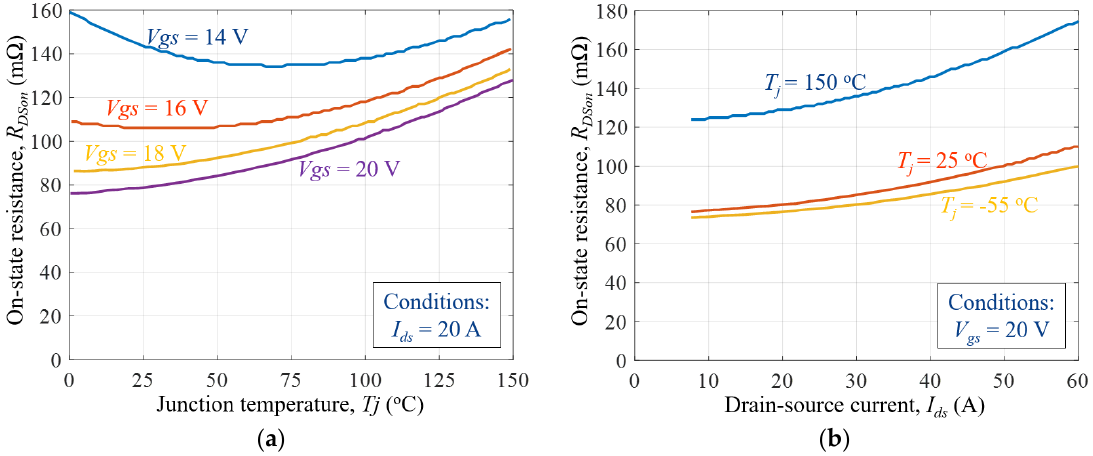
Figure 4. Variation of on-state resistance R DSon with ( a ) junction temperature T j and gate-source voltage V gs (on the left), and ( b ) the SiC MOSFET current I DS (on the right). Figures were extracted from the reference SiC MOSFET power module datasheet (CCS050M12CM2).